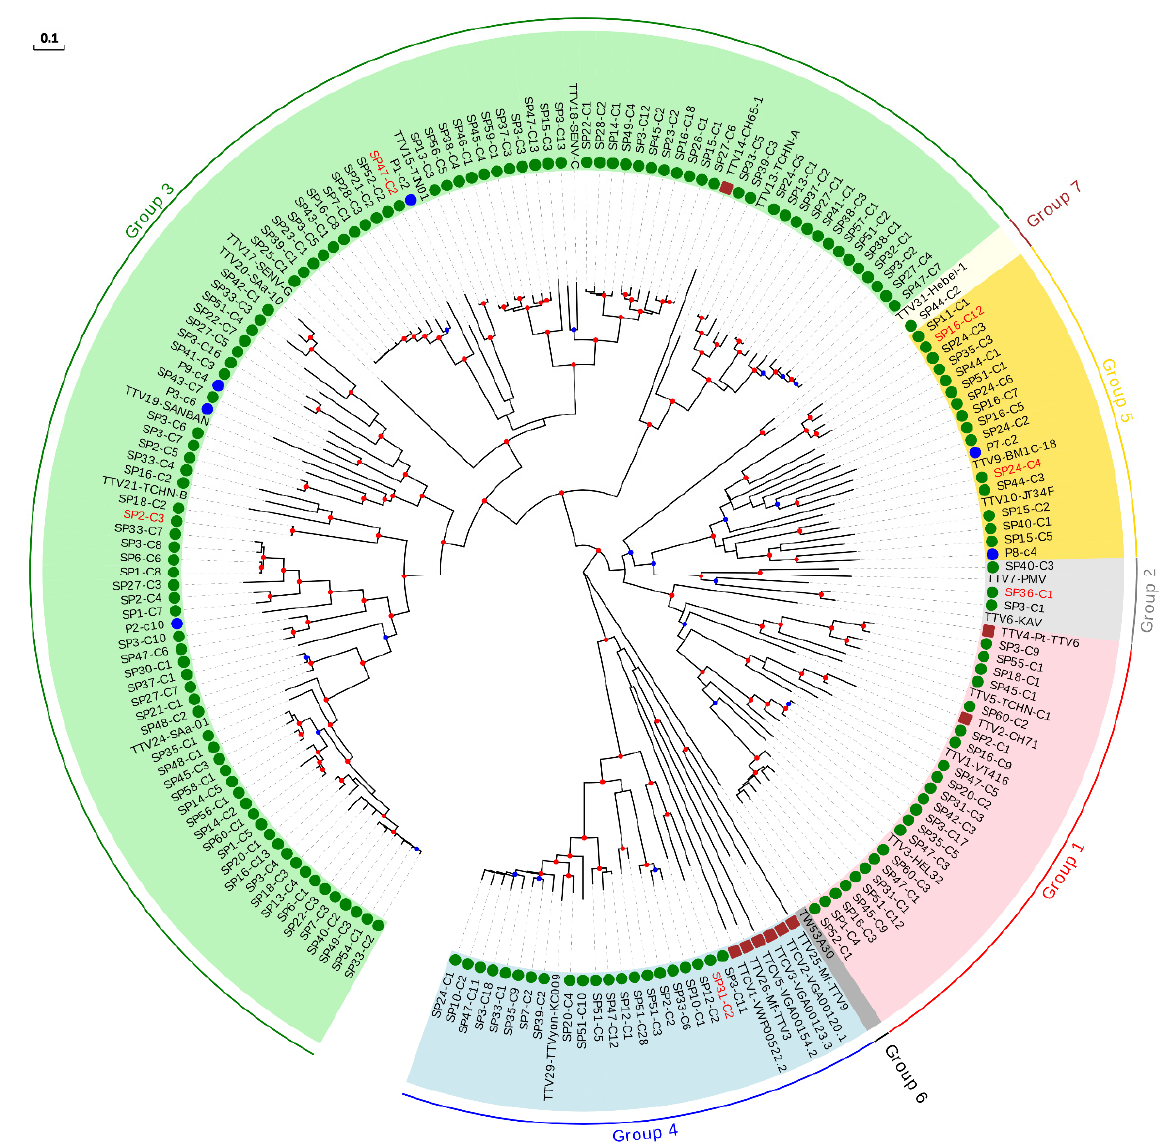
Figure 2. Phylogenetic tree of ORF1 sequences belonging to the TTV genus. Sequences described in this study are marked with a green circle. Those sequences that could be considered as new species are labeled in red. Sequences identified as new species after reevaluating data from our previous study [18] are marked with a blue circle. Non-hominid primate isolates are marked with a brown square. Nodes supported by bootstrap values ranging 0.7–0.85 and 0.85–1.0 are indicated with blue and red circles, respectively. The scale bar indicates the evolutionary distance in nucleotide substitutions per site.